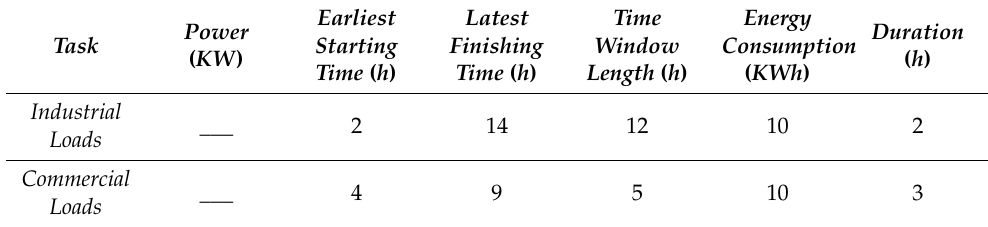
Table 2. Electricity consumption tasks.